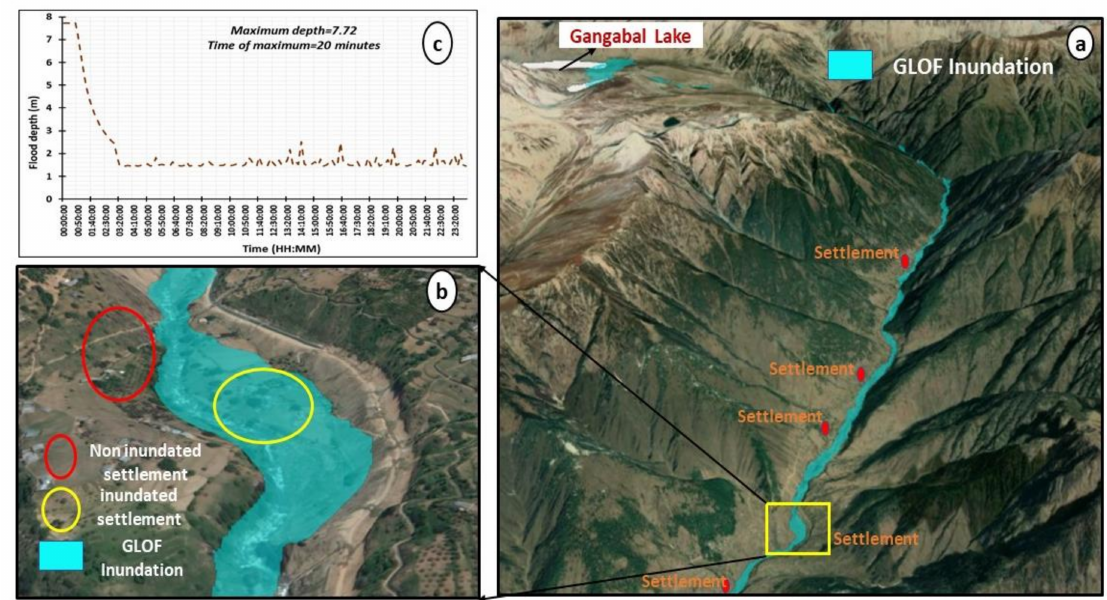
Figure 16. ( a ) GLOF propagation at various locations downstream; ( b ) zoomed view of the inundated settlement; ( c ) flood depth at Settlement